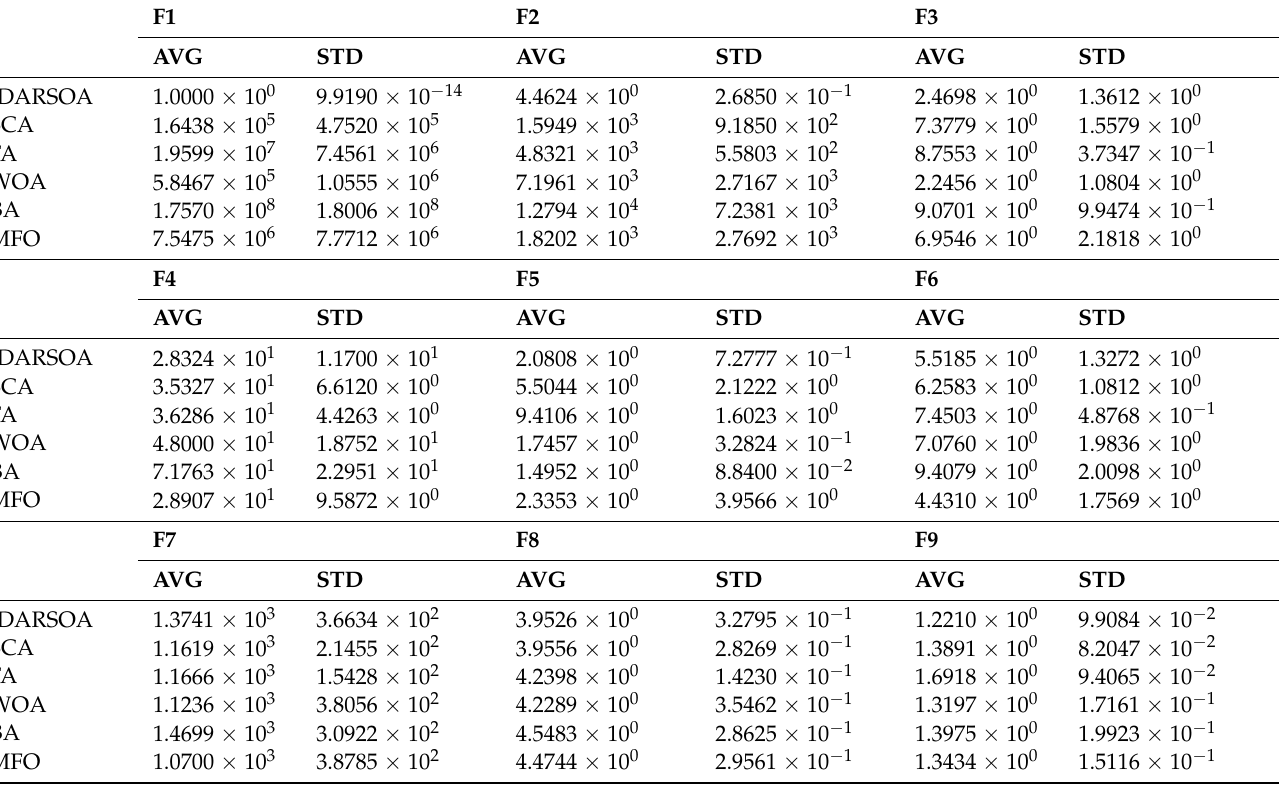
Table 8. Comparison of IDARSOA and original